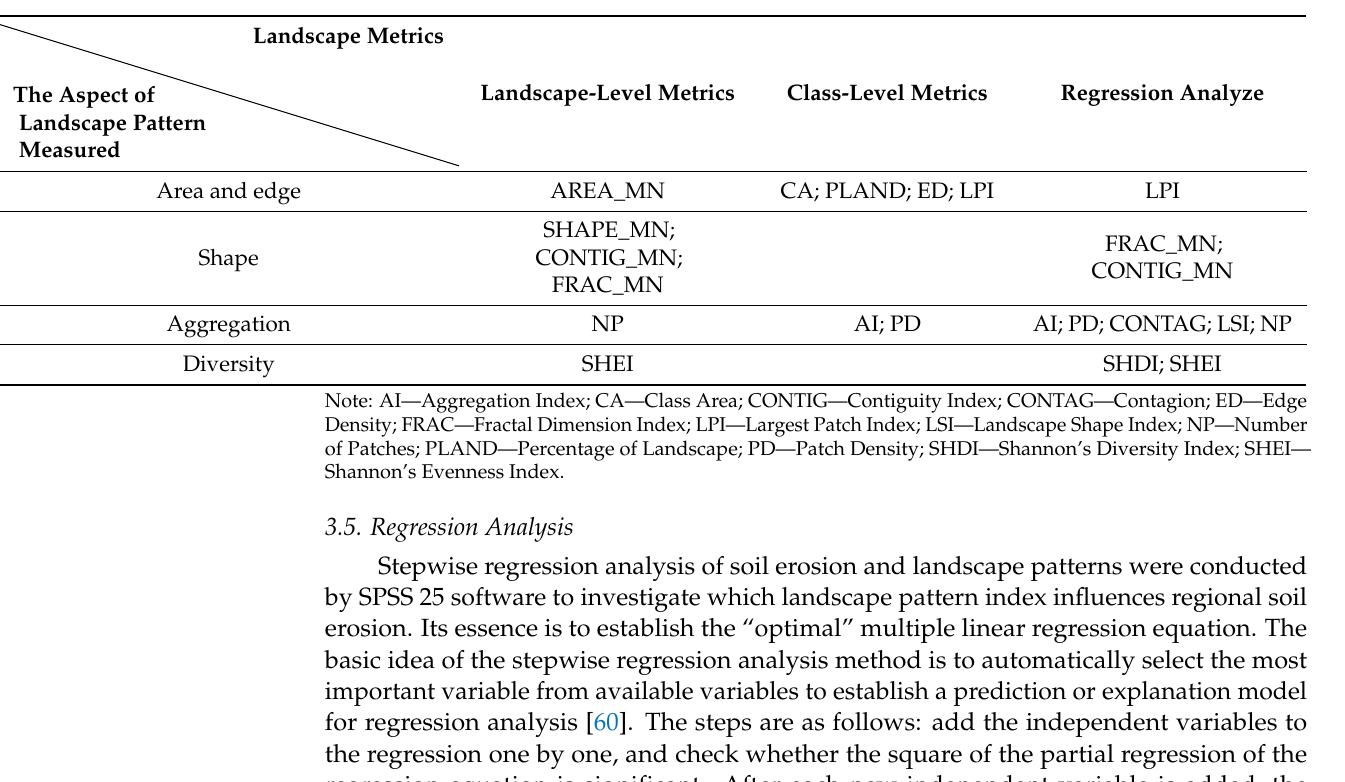
Landscape index selected at class-level analysis, landscape-level analysis, and regression